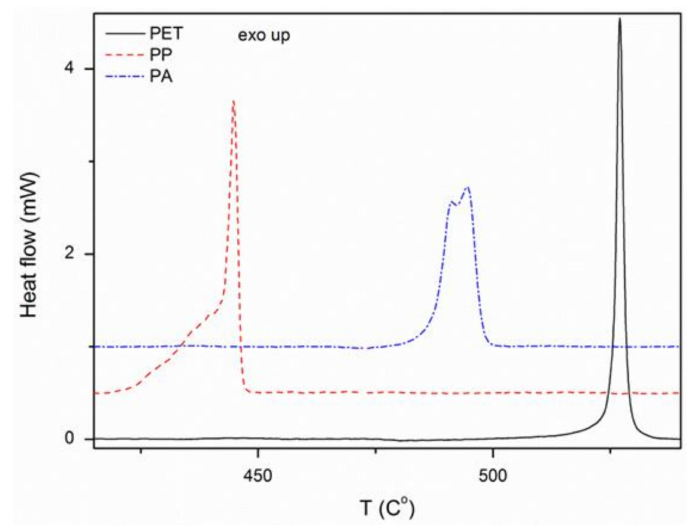
Figure 2. DSC analysis of the used textiles. Table 2. DSC results for analyzed textiles.